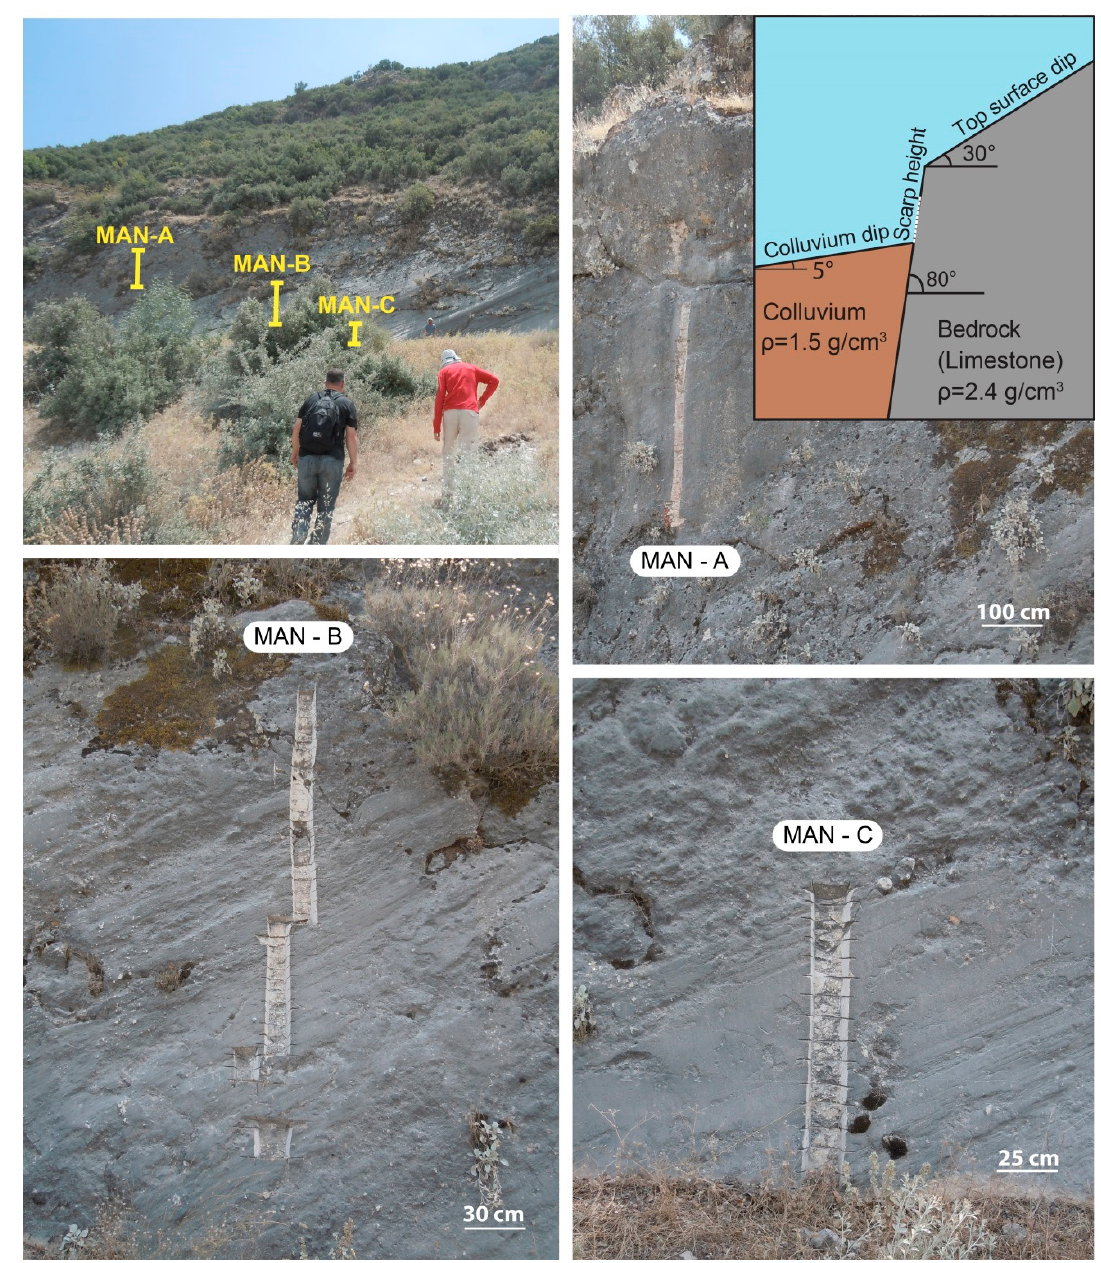
Figure 5. Manastır fault scarp, view towards SSW with three sampling strips of MAN-A, MAN-B and MAN-C. Note: lowest notch below MAN-B strip is not related to this study; Schematic sketch shows fault scarp with used parameters for modeling. White dashed line represents the sampled surface.